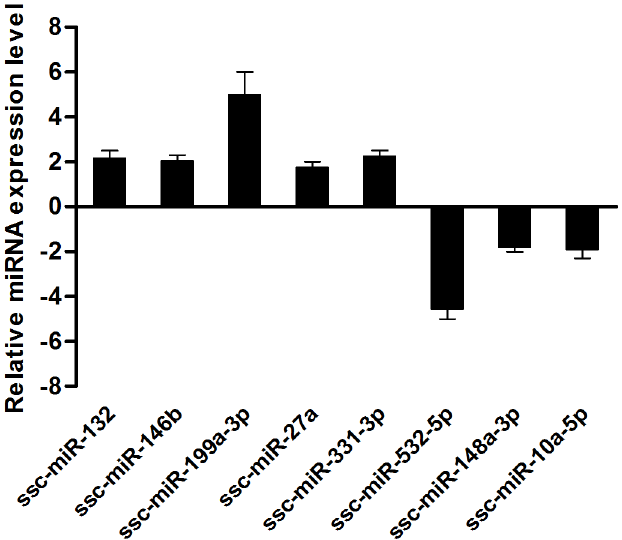
Fig 3. Validation of differentially expressed host miRNAs using stem-loop RT-qPCR. miRNAs expression levels were normalized to the U6 snRNA. The experiments were performed with at least three independent